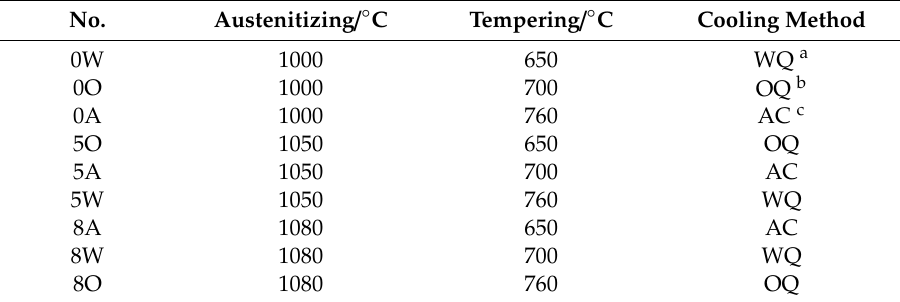
Table 2. Influence factors and parameters for the orthogonal design